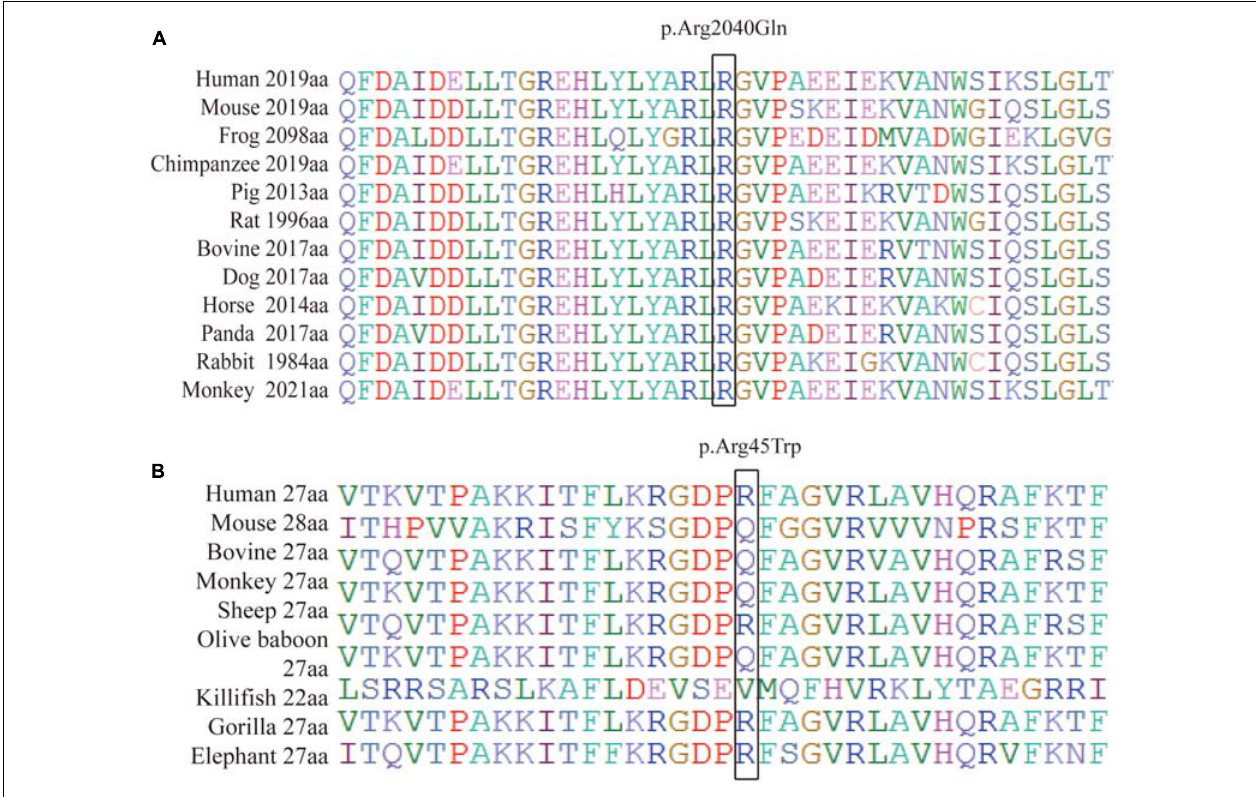
FIGURE 5 | Protein sequence alignment of human ABCA4 (A) and RP1L1 (B) with their orthologs. (A) Shows that codon 2040 (isoleucine) of ABCA4 and its subsequent sequences were highly conserved amino acids across different species. (B) Reveals that mutations of c.133 C > T in the RP1L1 gene were not conserved in the nine species